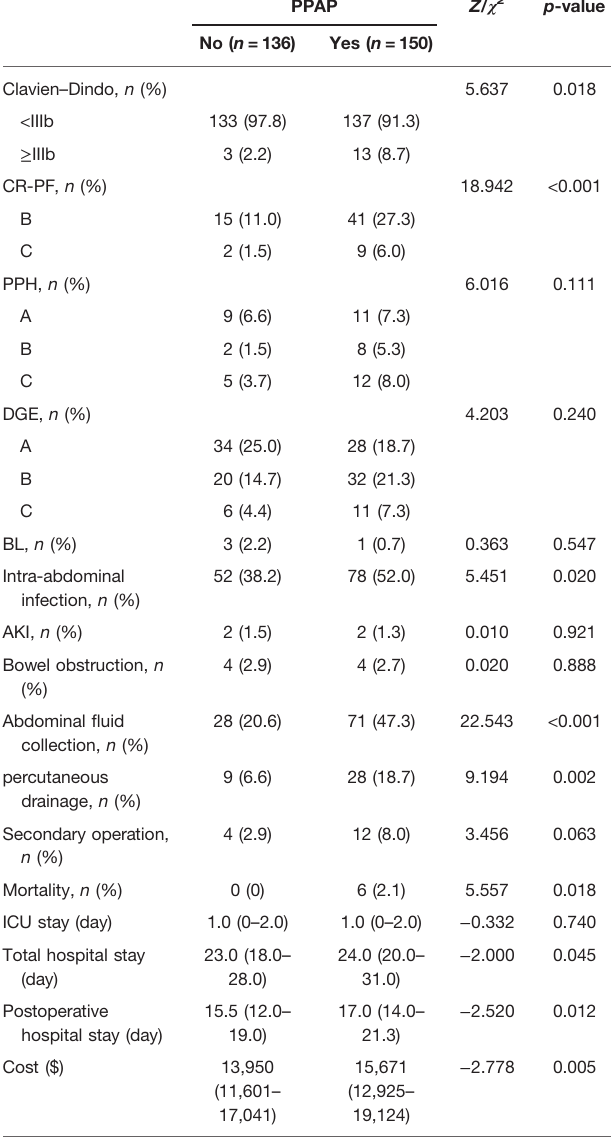
TABLE 1 | Postoperative outcomes strati fi ed by the occurrence of